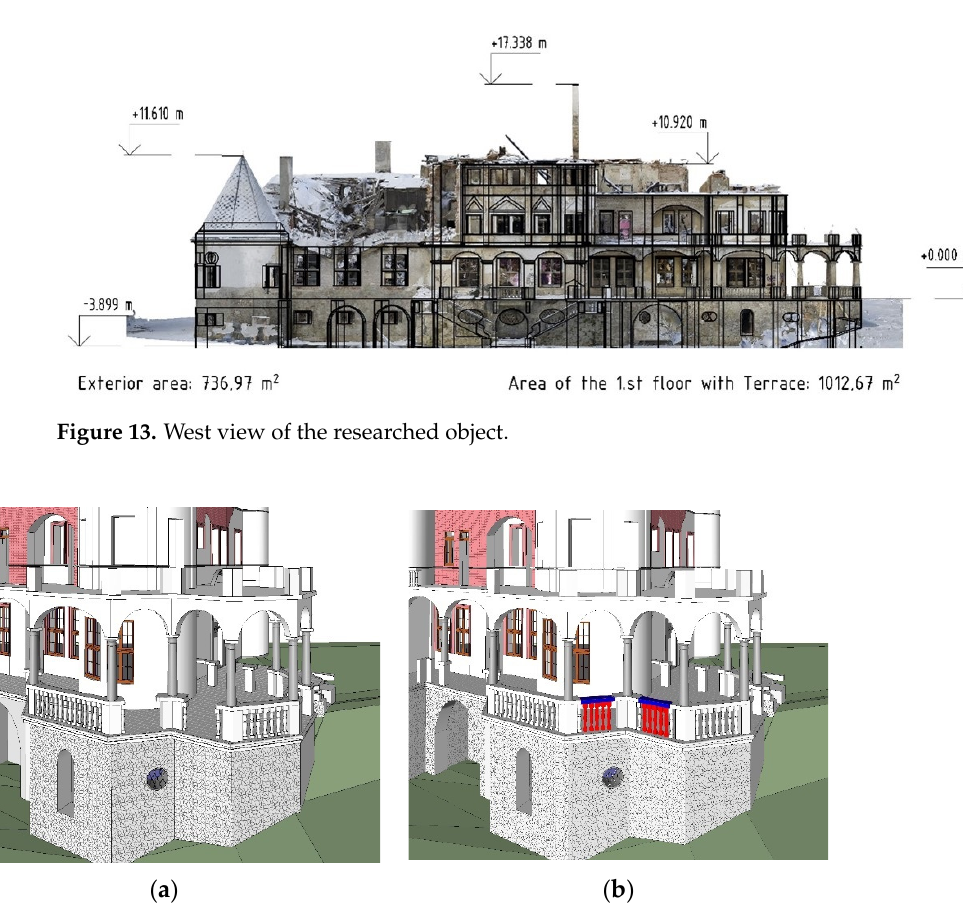
Figure 14. Original ( a ) and refurbished ( b ) baluster.